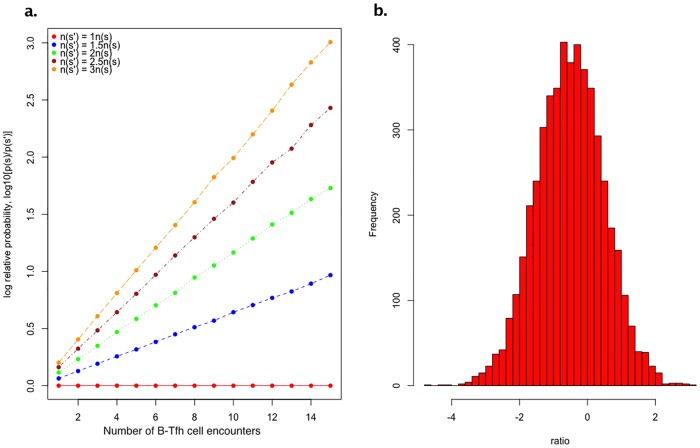
Relative probabilities of B cells with differing BCR sequences.A: Logplots of B cells with BCRs s′ and s as a function of the number, n, of B-Tfh cell encounters. To model individual B-Tfh reaction and apoptosis rates, we randomly sample the ratio of B cell loss rate to B-Tfh cell encounter rate constants, r[f, q; n(s)] from a lognormal probability distribution, with a mean of -0.5 (i.e the rate of B cell loss is on average a third smaller than rates of B-Tfh cell engagement), and a variance of 1.0 to allow for the possibility of a range of B-Tfh cell encounters, as shown in panel B. B: About 5000 such trajectories are generated and the total probability obtained by summing over all such trajectories.